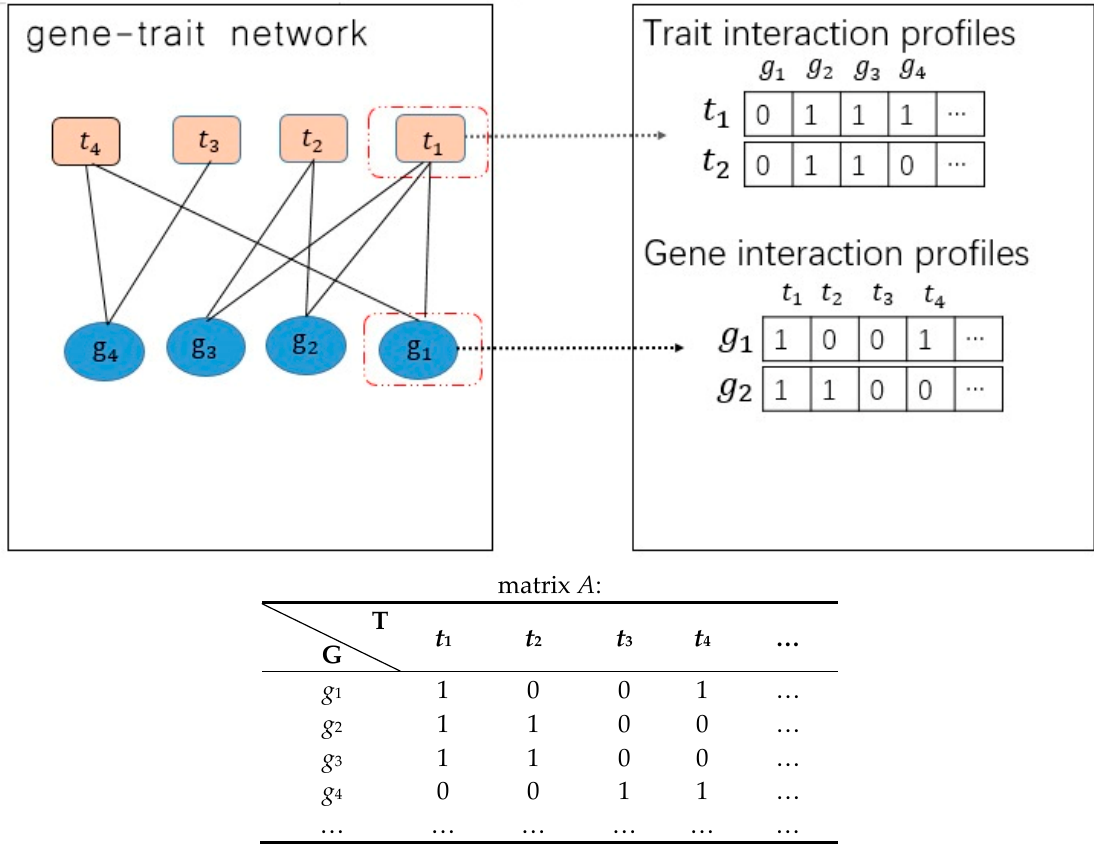
Figure 2. Description the use of a known gene–trait network to obtain trait interaction profiles, gene interaction profiles and the corresponding binary adjacency matrix A . The orange node represents the trait, and the blue node represents the gene in the network.